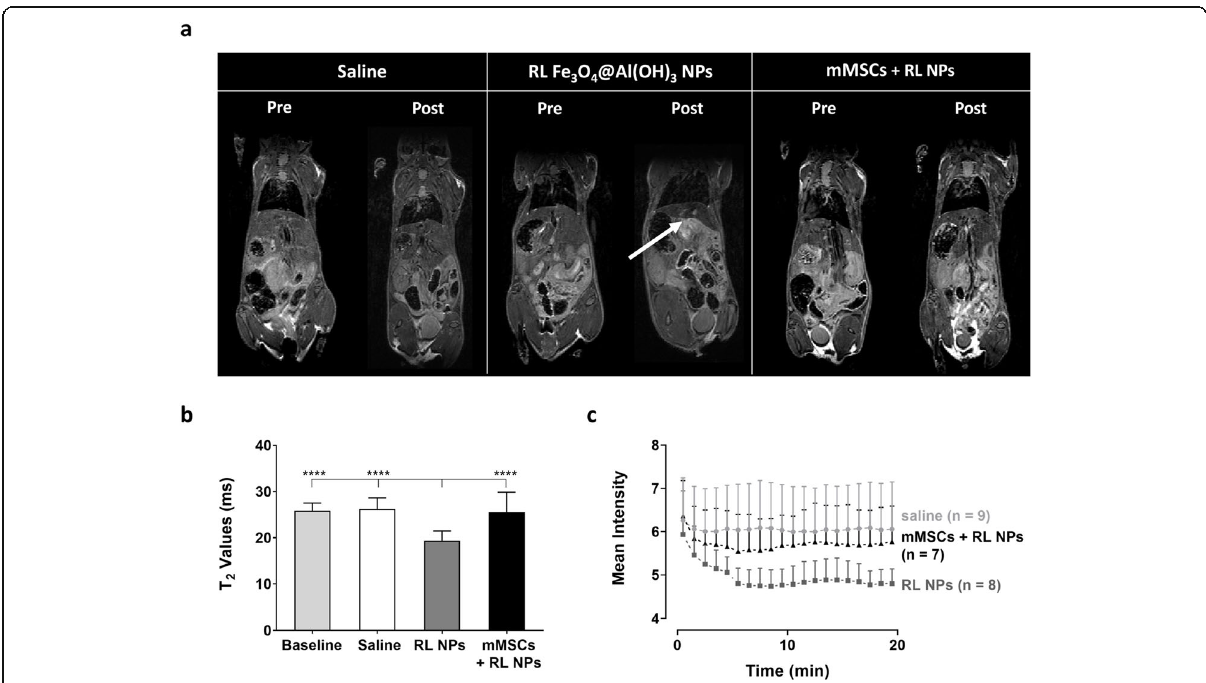
Fig. 4 Whole-body MRI for localization of 18 F-labeled Fe 3 O 4 @Al(OH) 3 NPs or mMSCs labeled with these NPs. A dynamic contrast enhanced (DCE) MRI, 3D T 2 -weighted anatomical MRI, and T2 map were acquired to study the biodistribution of 18 F-labeled Fe 3 O 4 @Al(OH) 3 NPs (RL NPs) and mMSCs labeled with RL NPs (mMSCs + RL NPs) in comparison with the control group (injection of saline). a A characteristic hypointense liver can be seen on the 3D T 2 -weighted anatomical scans after the injection of the RL NPs as indicated by the white arrow. b The significant decrease in T 2 values of the liver after injection of the RL NPs in comparison to baseline, the saline control and the mMSC + RL NPs group confirms the uptake of the NPs in the liver (one-way ANOVA with Bonferroni correction for multiple testing; **** p < 0. 0001). c DCE-MRI further confirms the uptake of RL NPs by the significant decrease in mean signal intensity in the liver 5 min after injection ( p < 0.05 when compared to baseline; two- way repeated-measures ANOVA with Bonferroni